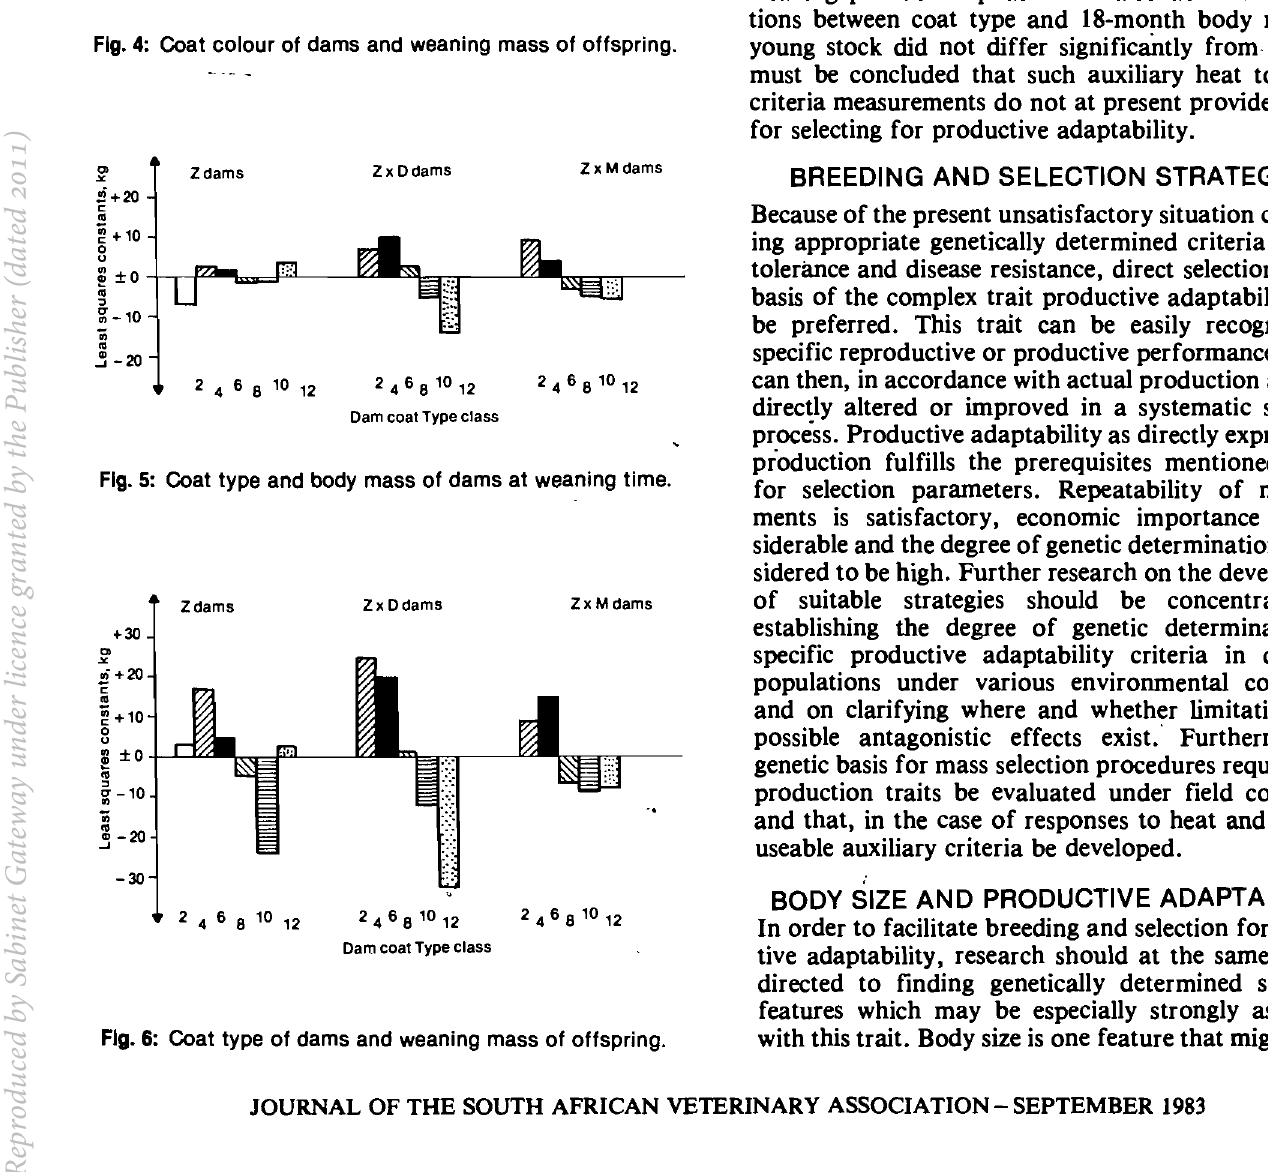
Fig. 4: Coat colour of dams and weaning mass of offspring.